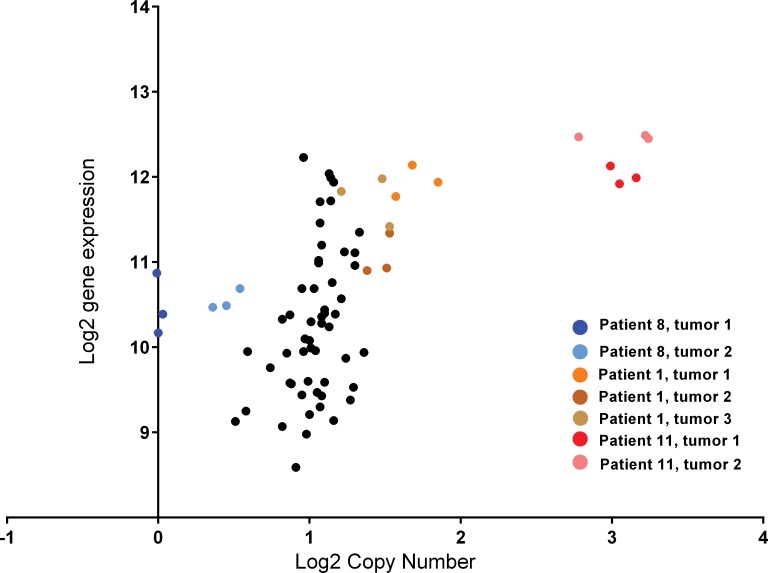
CCND1 gene expression and gene copy number in 11 MF ILC patients.Patient 8 (blue) deletion; Patient 1 (orange/brown) moderate copy number gain; Patient 11 (red/pink) high copy number gain.